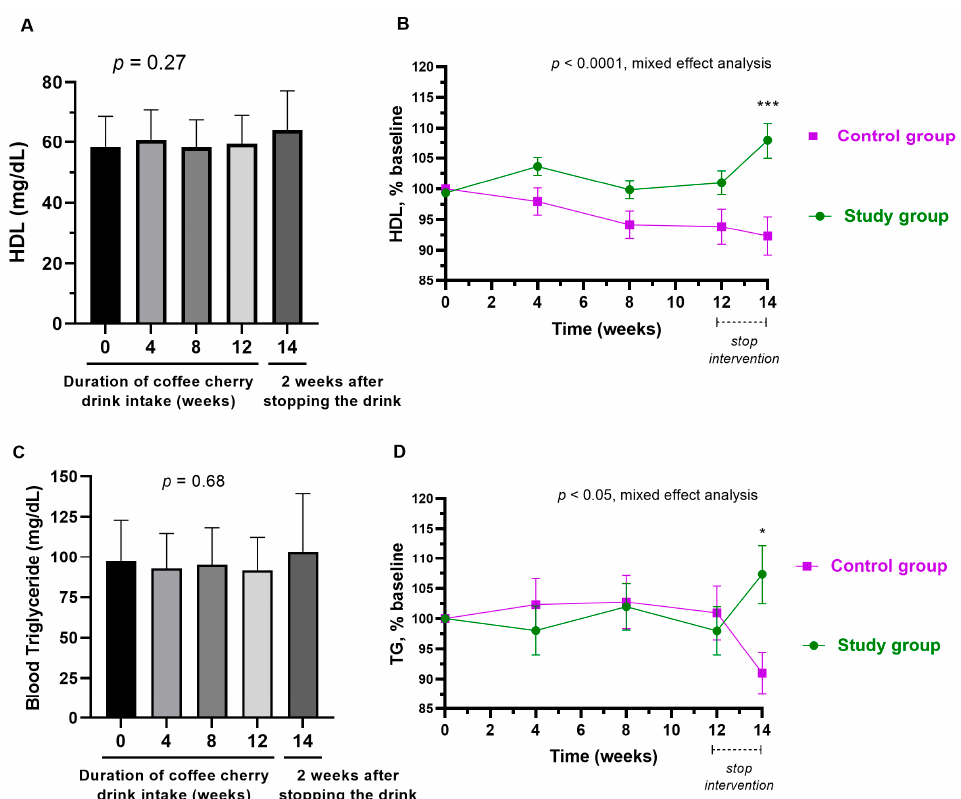
Figure 6. Changes in HDL and triglyceride. The bar graphs show the mean and standard deviation of HDL ( A ) and triglyceride ( C ) after consumption of cherry coffee pulp juice concentrate for 4, 8, and 12 weeks, and 2 weeks after stopping the intervention (14 weeks), with p -value obtained from the Kruskal–Wallis test; the line graphs show a comparison of the mean and standard deviation of the HDL ( B ) and triglyceride ( D ) in the percentage of the respective baseline values (% baseline) at each time point between study (green) and control (purple) groups, with p -value obtained from mixed-effect analysis. *, and *** mean p < 0.05, and 0.001, respectively.